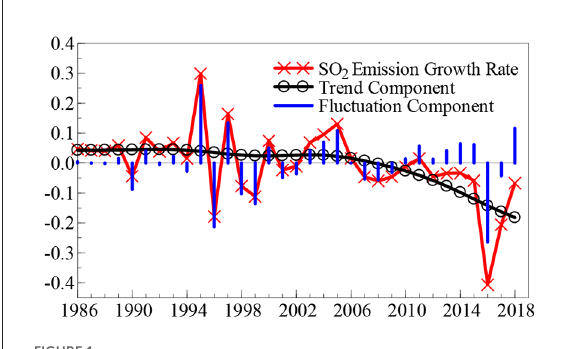
FIGURE1 Time dynamic path of SO 2 emission growth rate.